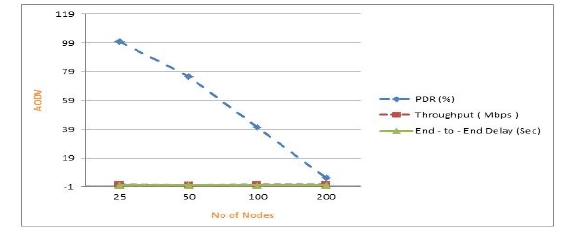
Fig. 5: AODV with all performance matrices From Fig. 6, it is observed that all metrics started with